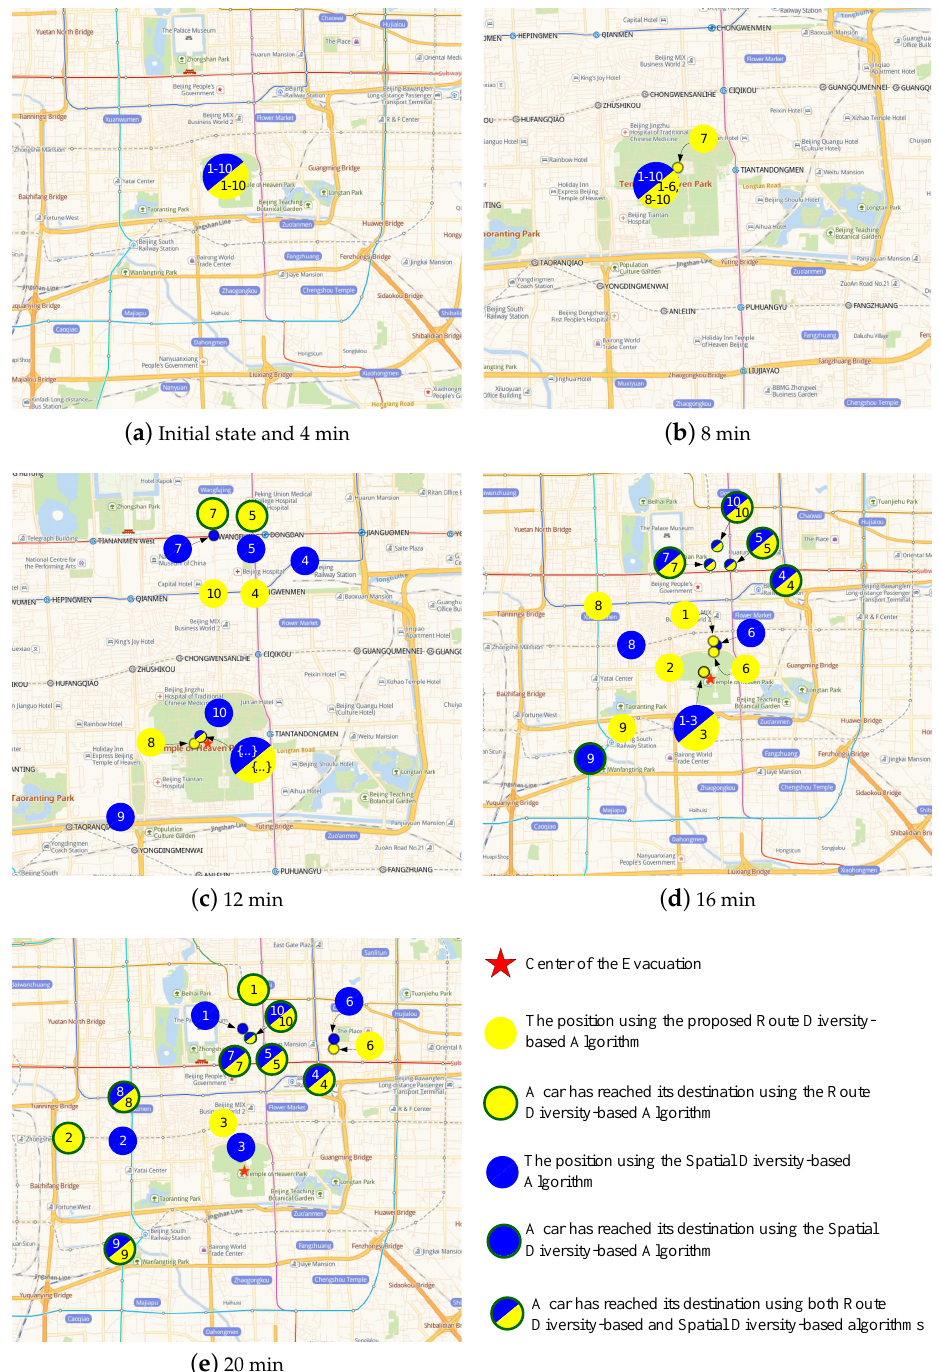
Figure 10. Simulation locations of the random selected (from 5000) vehicles to be evacuated at different